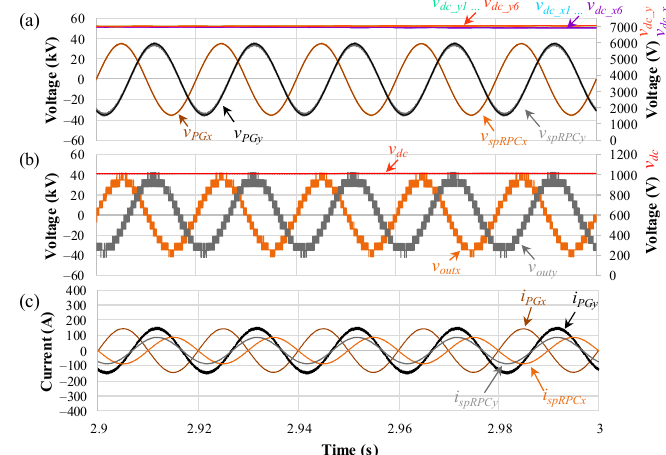
Figure 17. Detailed real-scale simulation results during the time interval from 2.9 s to 3 s: ( a ) the voltages on each TPS, v PGx and v PGy , the output voltages of the sp RPCx and sp RPCy , v spRPCx and v spRPCy , and voltages on the dc-link of each submodule, v dc_x1 to v dc_x6 , and v dc_y1 to v dc_y6 ; ( b ) the multilevel voltage of the spRPCx and spRPCy , v outx and v outy , and the voltage of the common dc-link voltage, v dc ; ( c ) the currents on each TPS, i PGx and i PGy , and the output currents of the sp-RPC, i spRPCx and i spRPCy .